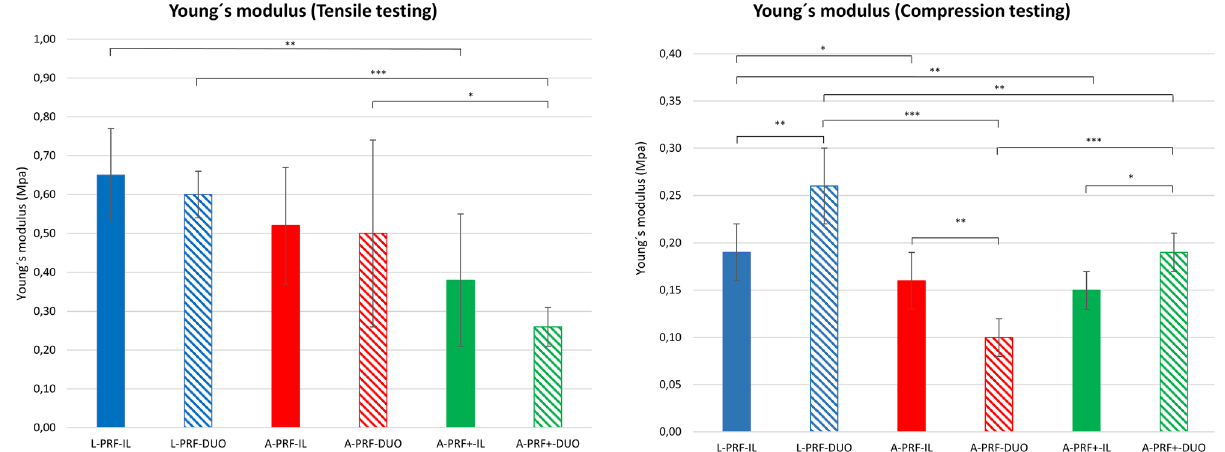
Figure 4. Graphical representation of the compression tests and tensile tests. Data from eight participants. * p < 0.05, ** p < 0.01, *** p < 0.001.